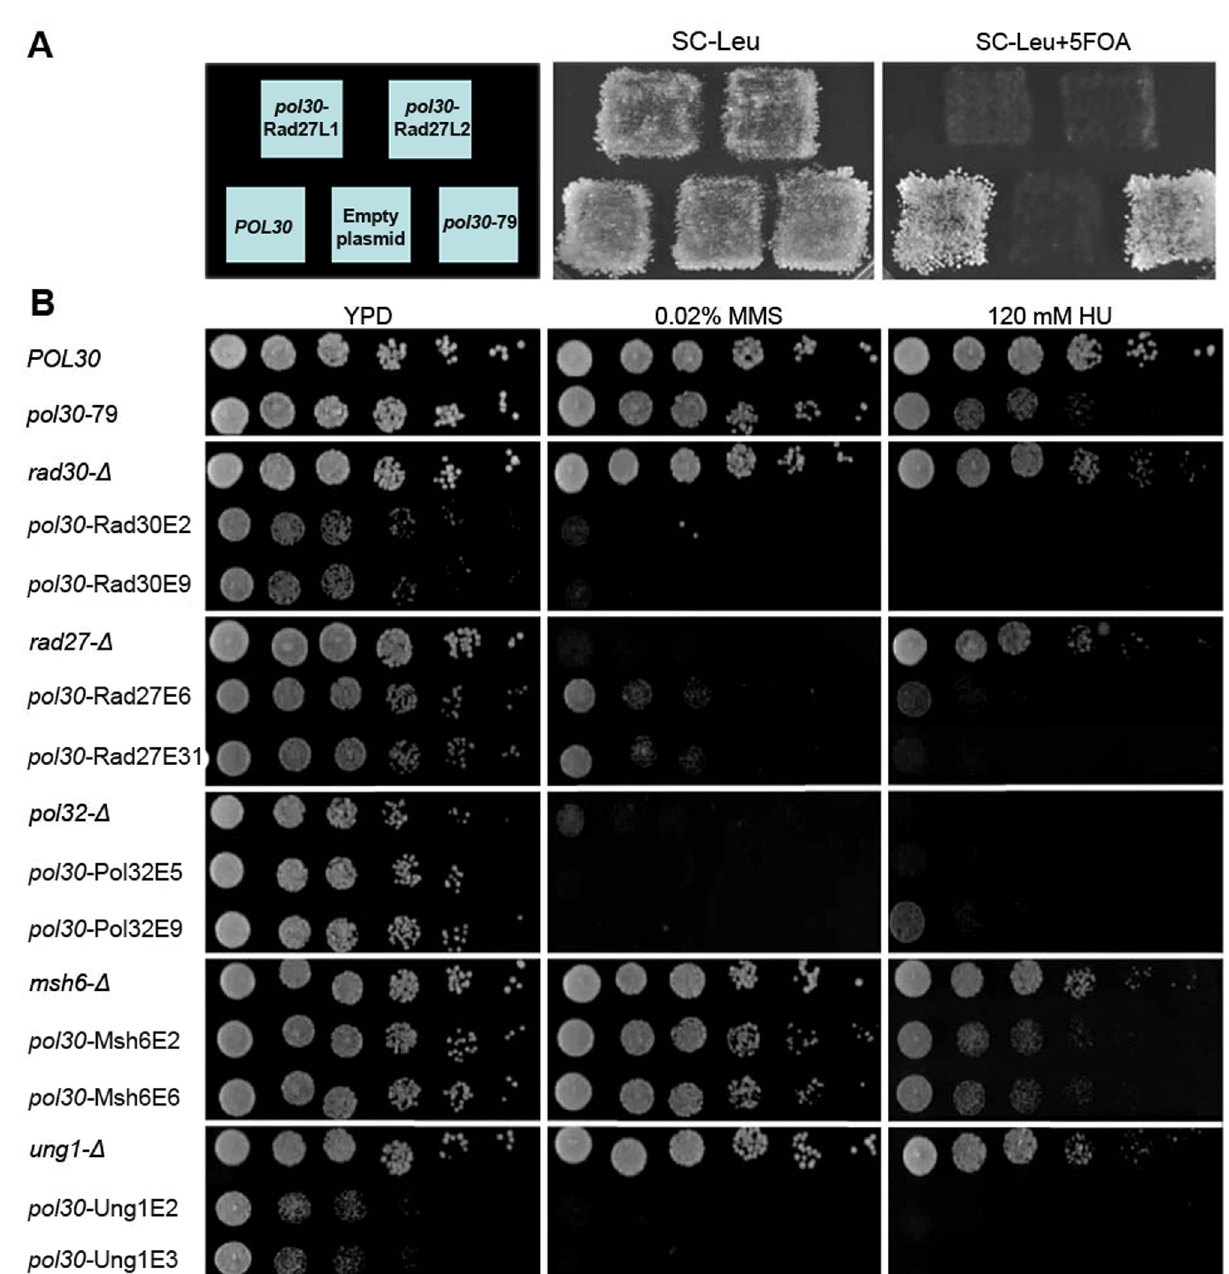
Figure 5. In vivo phenotypic analysis of PCNA mutants. (A) Non-viable strains containing PCNA mutants with increased binding affinity for Rad27 as the sole version of PCNA. Yeast strains containing WT PCNA expressed from a URA3 plasmid and mutant PCNA genes expressed from a LEU2 plasmid are viable (middle). Upon selection for loss of WT PCNA using 5-floororotic acid (5FOA), PCNA mutant strains are non-viable (right). (B) MMS (middle) and HU (right) sensitivity of strains containing PCNA mutants with increased binding affinity for Rad27, Pol32, Rad30, Msh6, and Ung1 and strains containing WT PCNA in which the same partners were deleted. For binding characterization and sequences of the mutants, see Table 1.